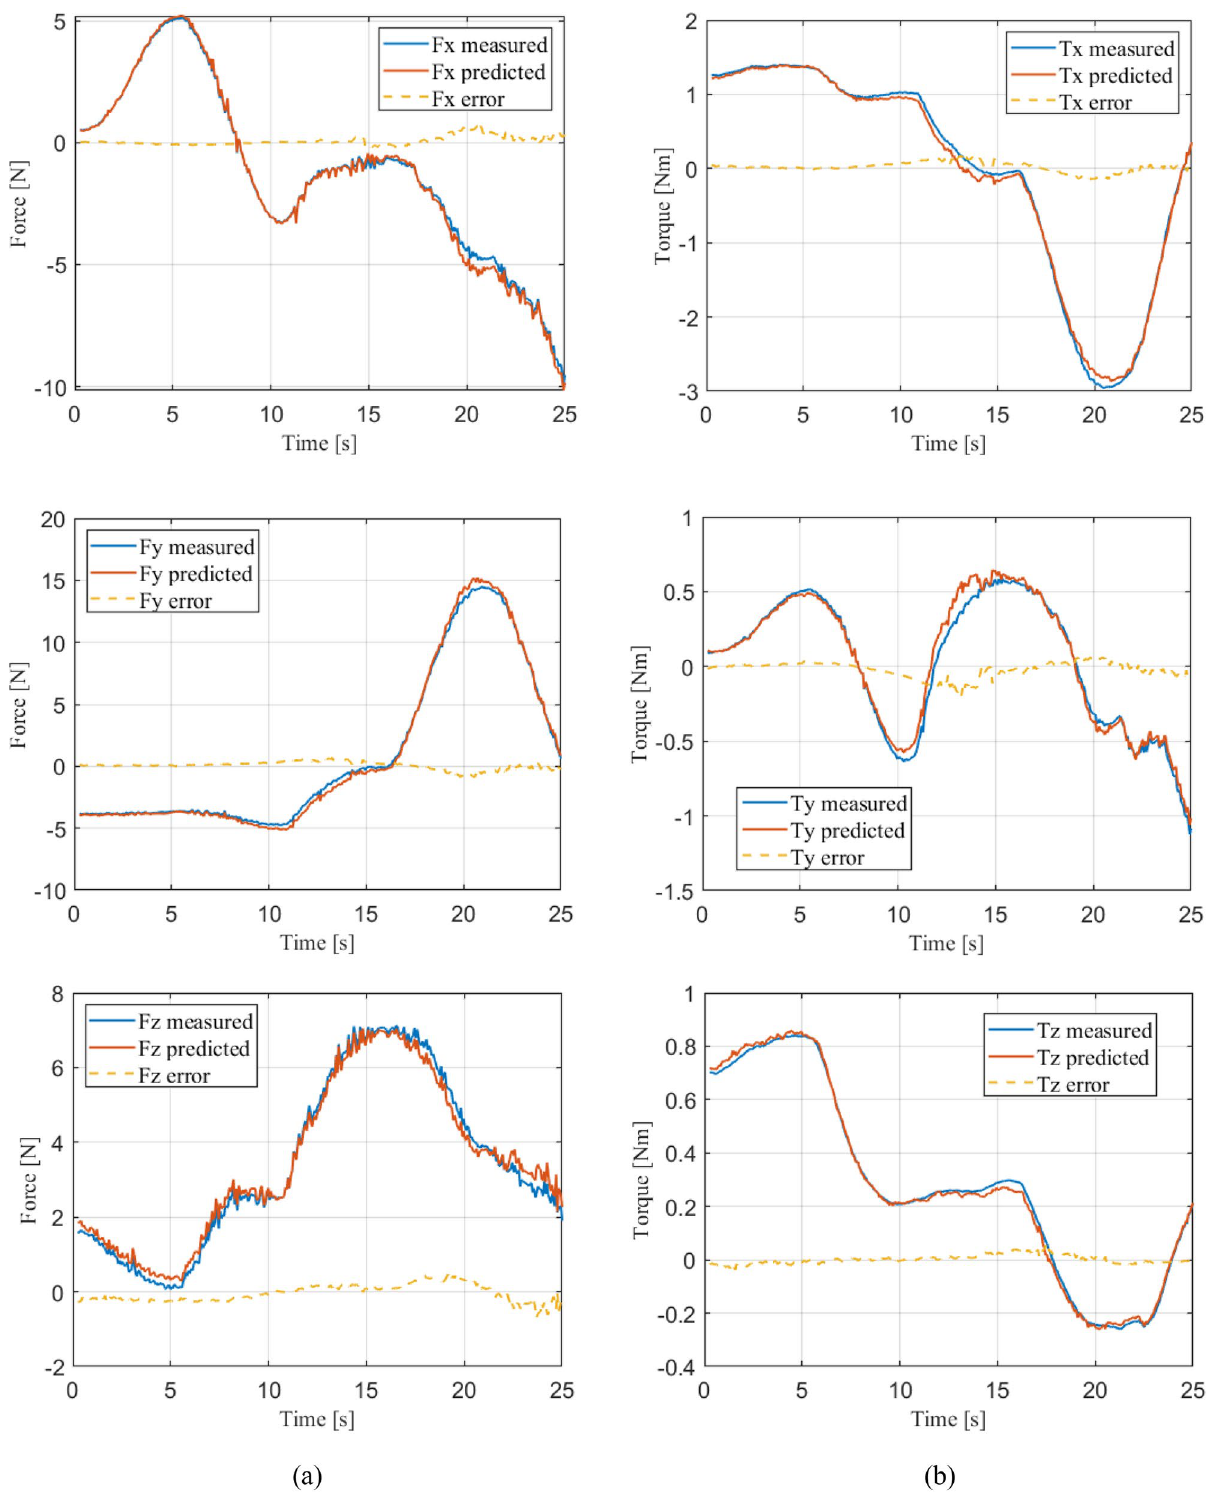
Figure 8. The estimation performance of our method in a real manipulation